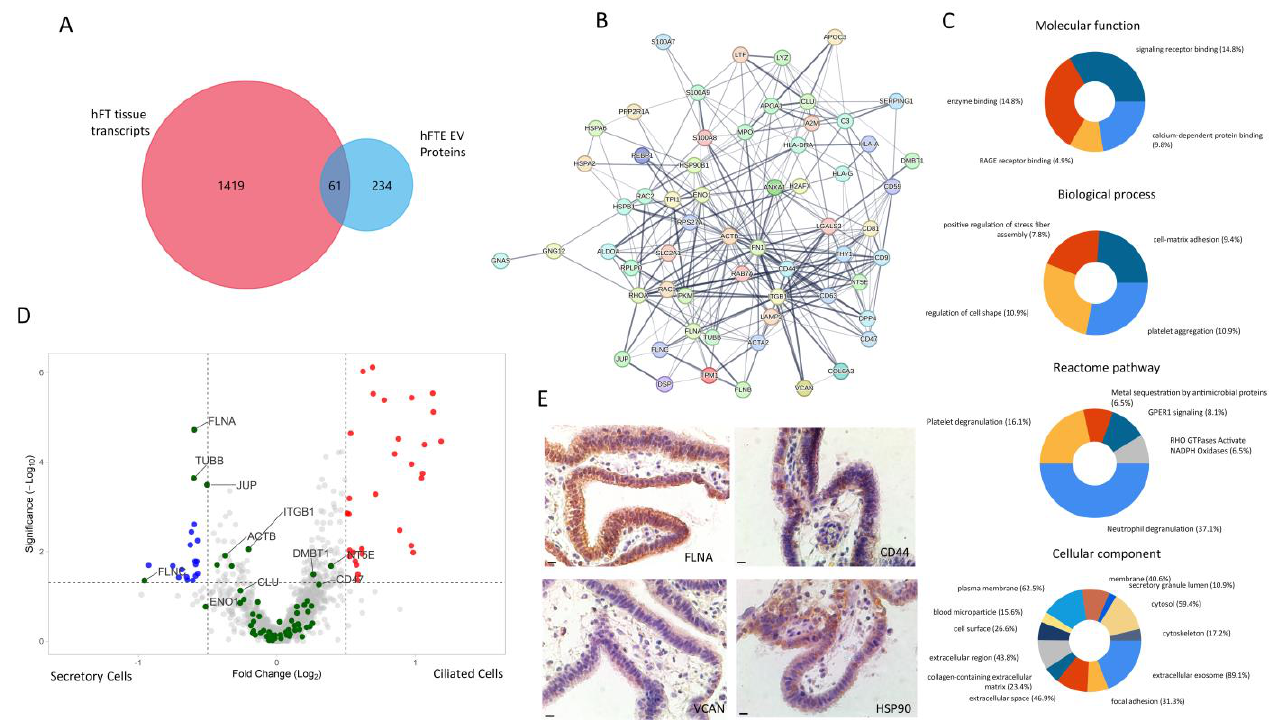
Figure 5. Correlation of fallopian tube tissue transcriptomics profile with a hFTE sEV proteomics profile. ( A ) Comparison between hFTE sEV proteins with hFT tissue transcripts (CTA database, GeoMx) of ciliated and secretory cells identified by GeoMx digital spatial imaging showing 61 common gene IDs. ( B ) Protein − protein interaction network of the 61 common gene IDs via STRING. ( C ) Gene enrichment analysis of 61 common genes showing molecular functions, biological processes, Reactome pathways, and cellular components associated with 61 common genes, using the FUNRICH software. The percentage in the pie chart description represents the percentage of genes out of 61 common genes responsible for particular events. ( D ) The differential expression of genes in ciliated vs. secretory cells in fallopian tube tissue. The green dots represent 61 common gene IDs between the hFTE transcriptome and hFTE sEV proteomics. Four (FLNA, TUBB, JUP, and FLNC) out of 61 genes were significantly upregulated in secretory cells. Blue and red dots are differentially expressed genes in secretory and ciliated cells, respectively. ( E ) IHC staining of representative proteins of 61 common genes expressed in fallopian tube tissue and sEVs. Scale bar = 10 µm.